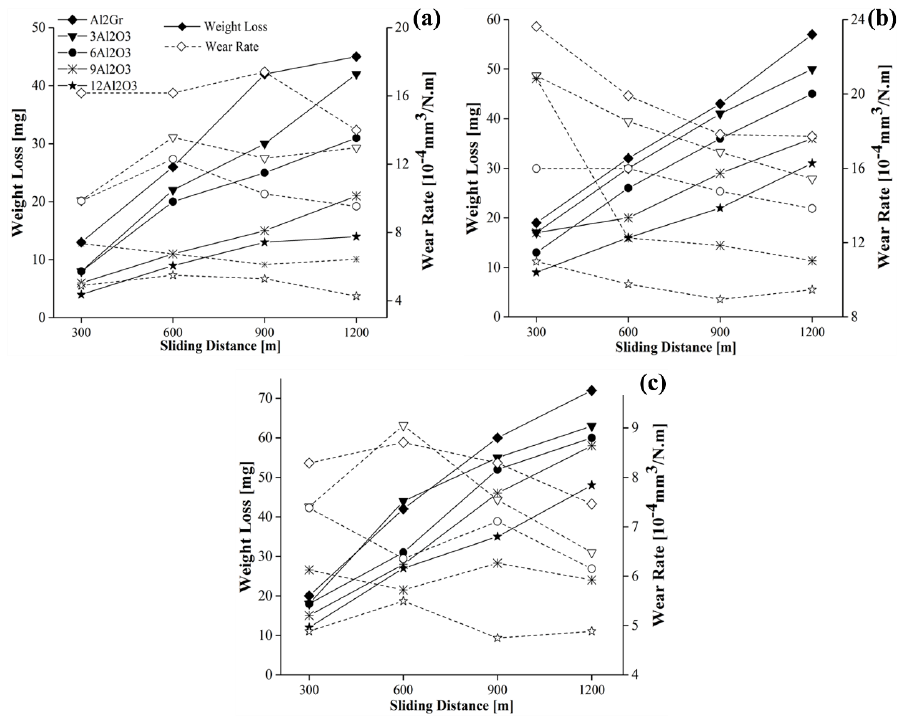
Figure 4: Weight losses and wear rates under different loads of composite materials with different amounts of Al 2 O 3 reinforced; 10 N (a), 20 N (b), and 30 N (c).